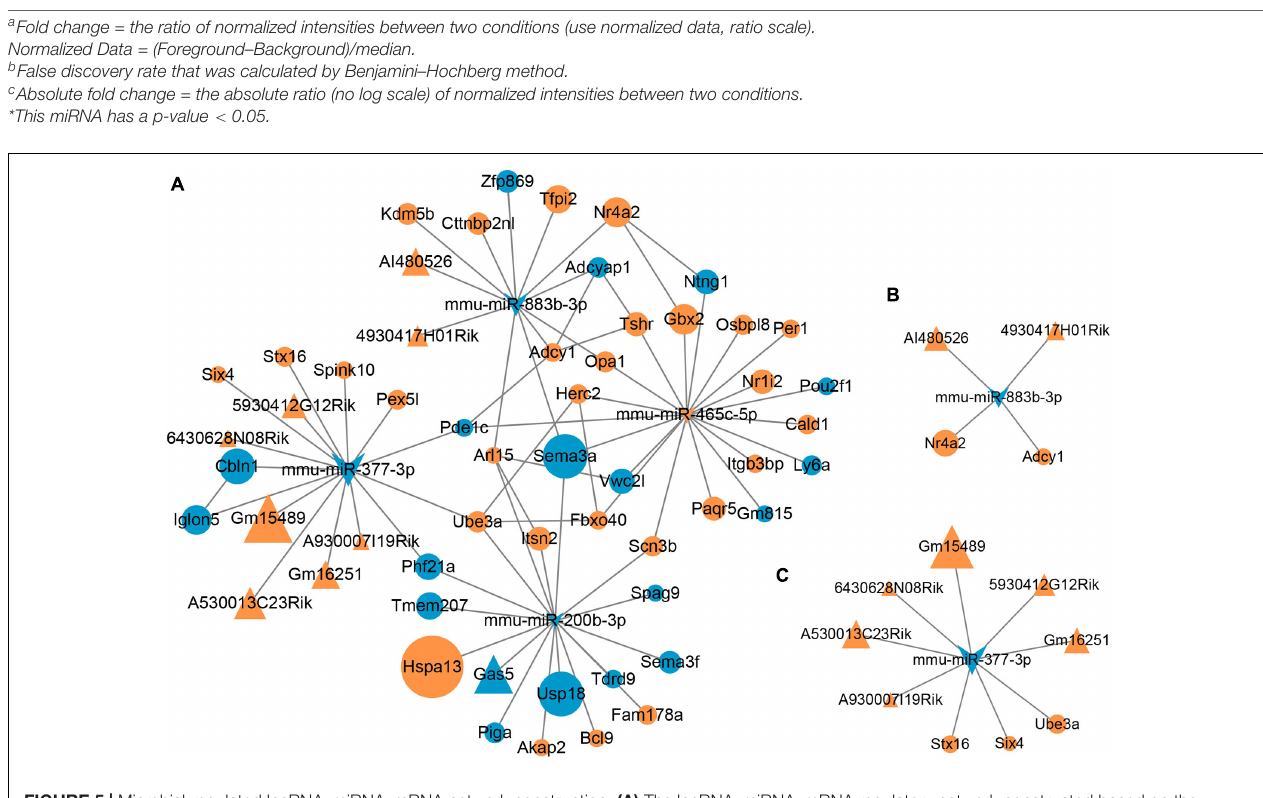
FIGURE 5 | Microbial-regulated lncRNA–miRNA–mRNA network construction. (A) The lncRNA–miRNA–mRNA regulatory network constructed based on the RNA–RNA interactions. (B,C) Two ceRNA sub-networks involved in neurodevelopment were constructed according to the ceRNAs